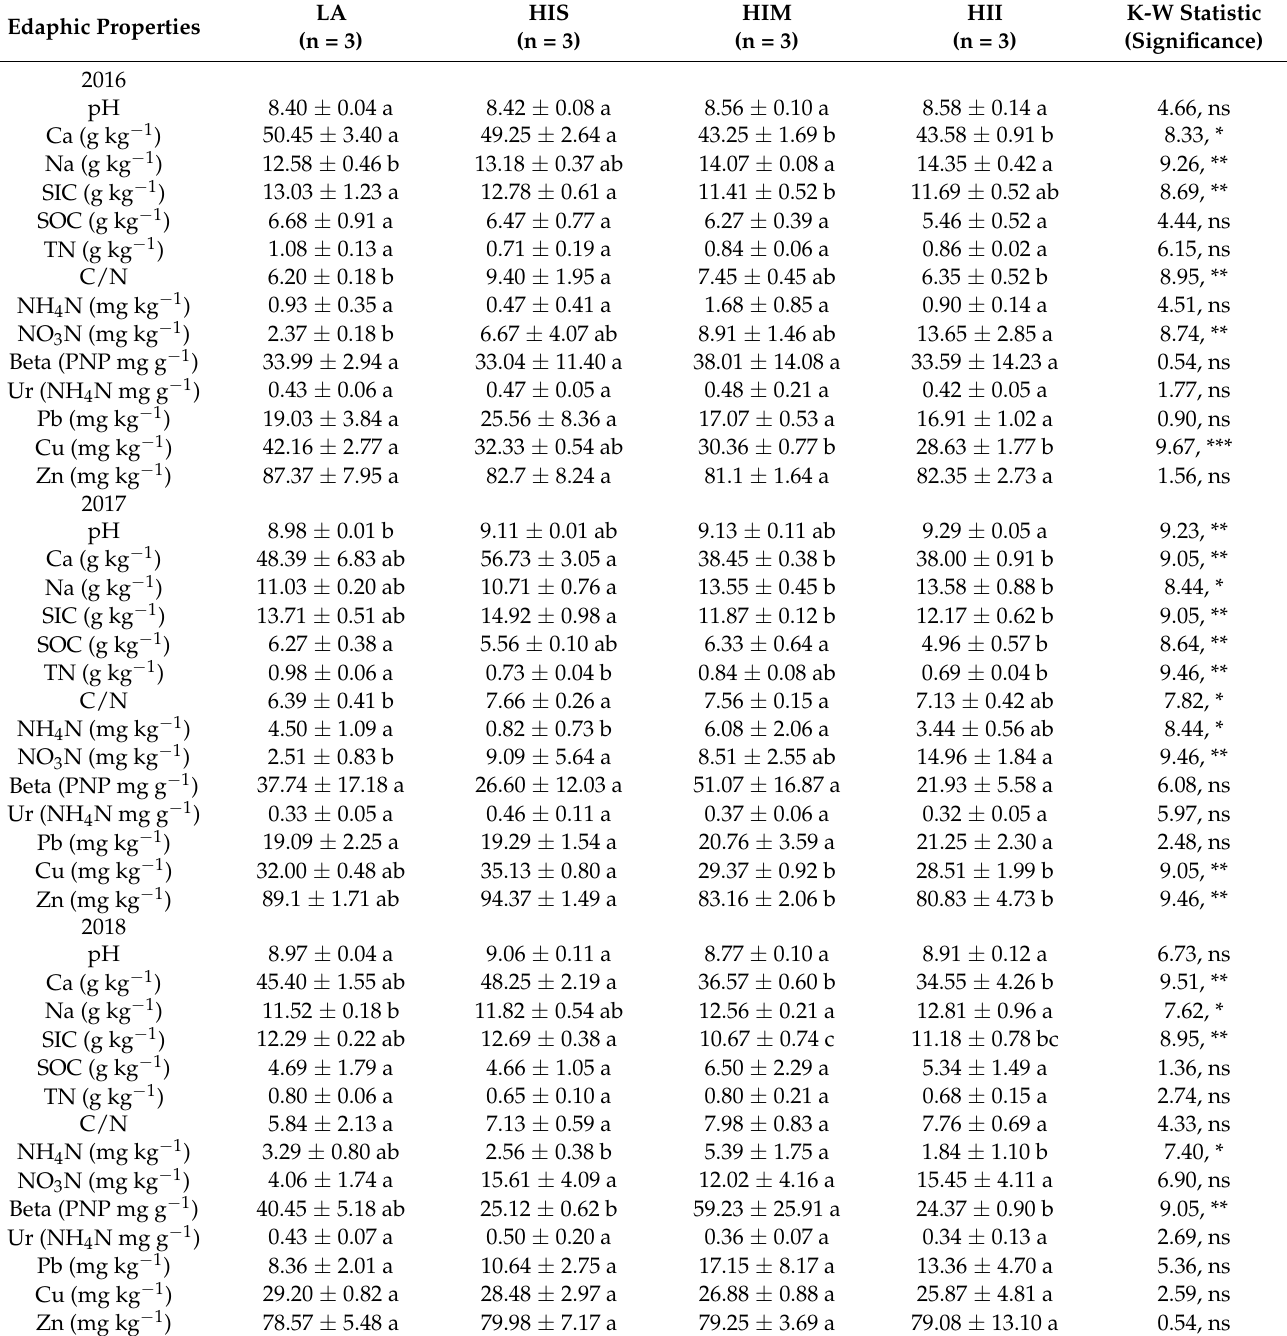
Table 1. The differences in edaphic properties are caused by human